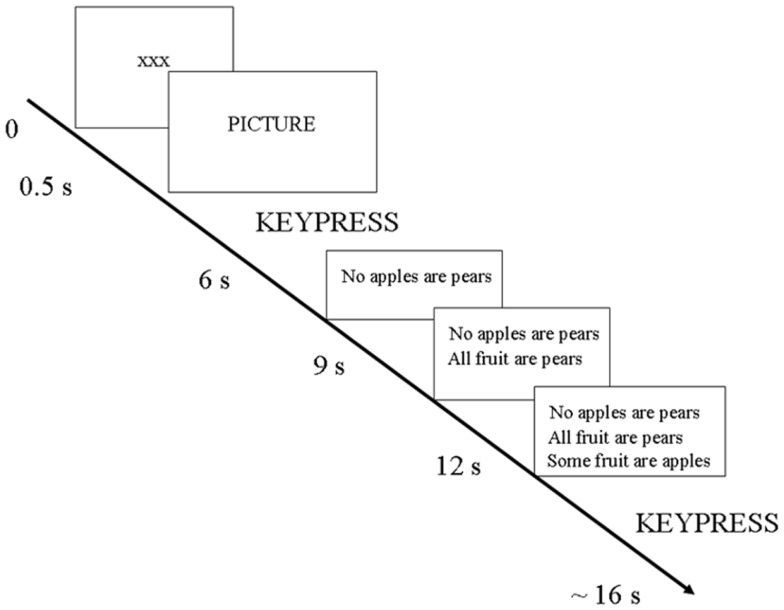
Design of one trial.